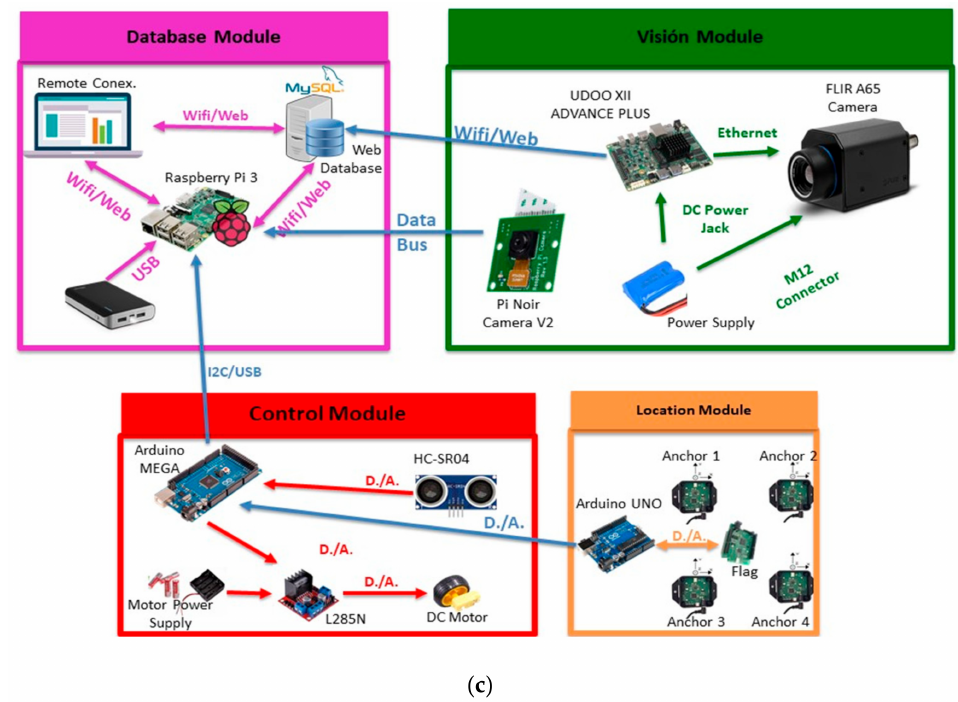
Figure 7. Autonomous indoor navigation device. ( a ) Frontal, ( b ) lateral, ( c ) connection